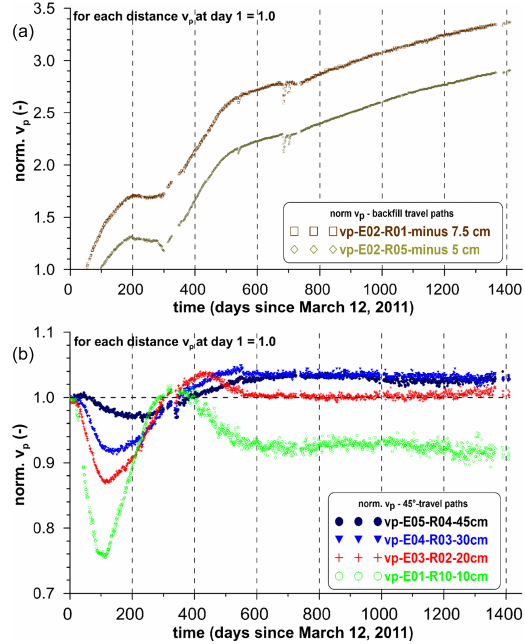
Figure 8. Seismic transmission long-term monitoring within the HE-E experiment via normalised v p -evolution. (a) In the back fill (sand-bentonite) at distances of 7.5 and 5cm from the transition; (b) in the Opalinus Clay at four distances from the transition and ray paths running under 45 ◦ towards the bedding (after Schuster,